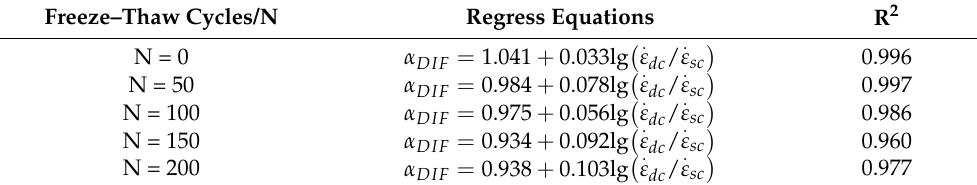
( b ) Figure 14. Variation of mechanical properties of concrete specimens under frost damage. ( a ) Flexural strength, ( b ) split- ting tensile strength.